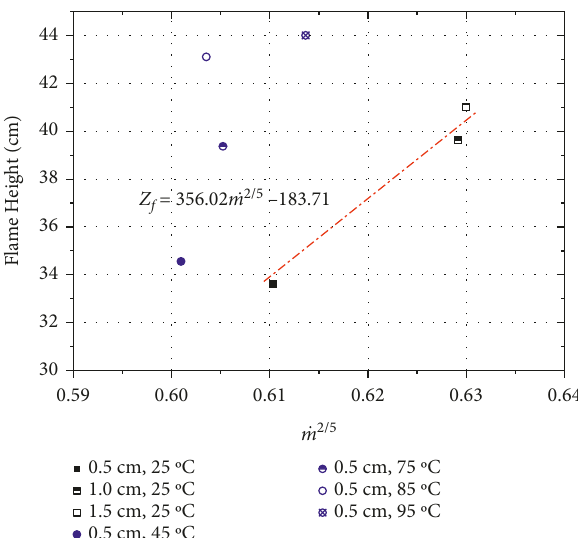
Figure 5: Flame height as a function of _ m 2/5 for different exper- imental conditions.